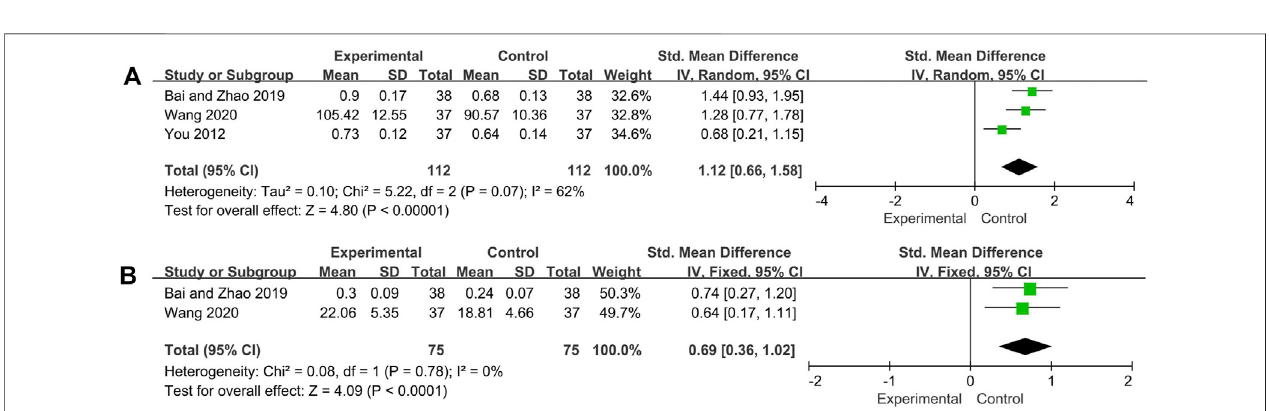
FIGURE 5 | Forest plot of C3 (A) and C4 (B) .